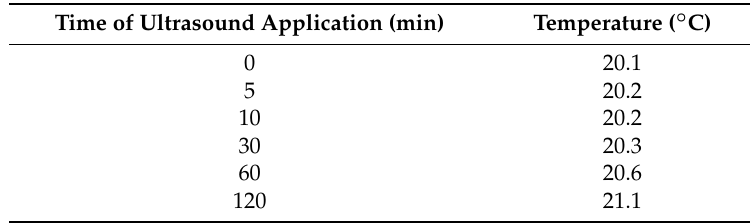
Temperature measurements inside the treatment chamber at different ultrasound application